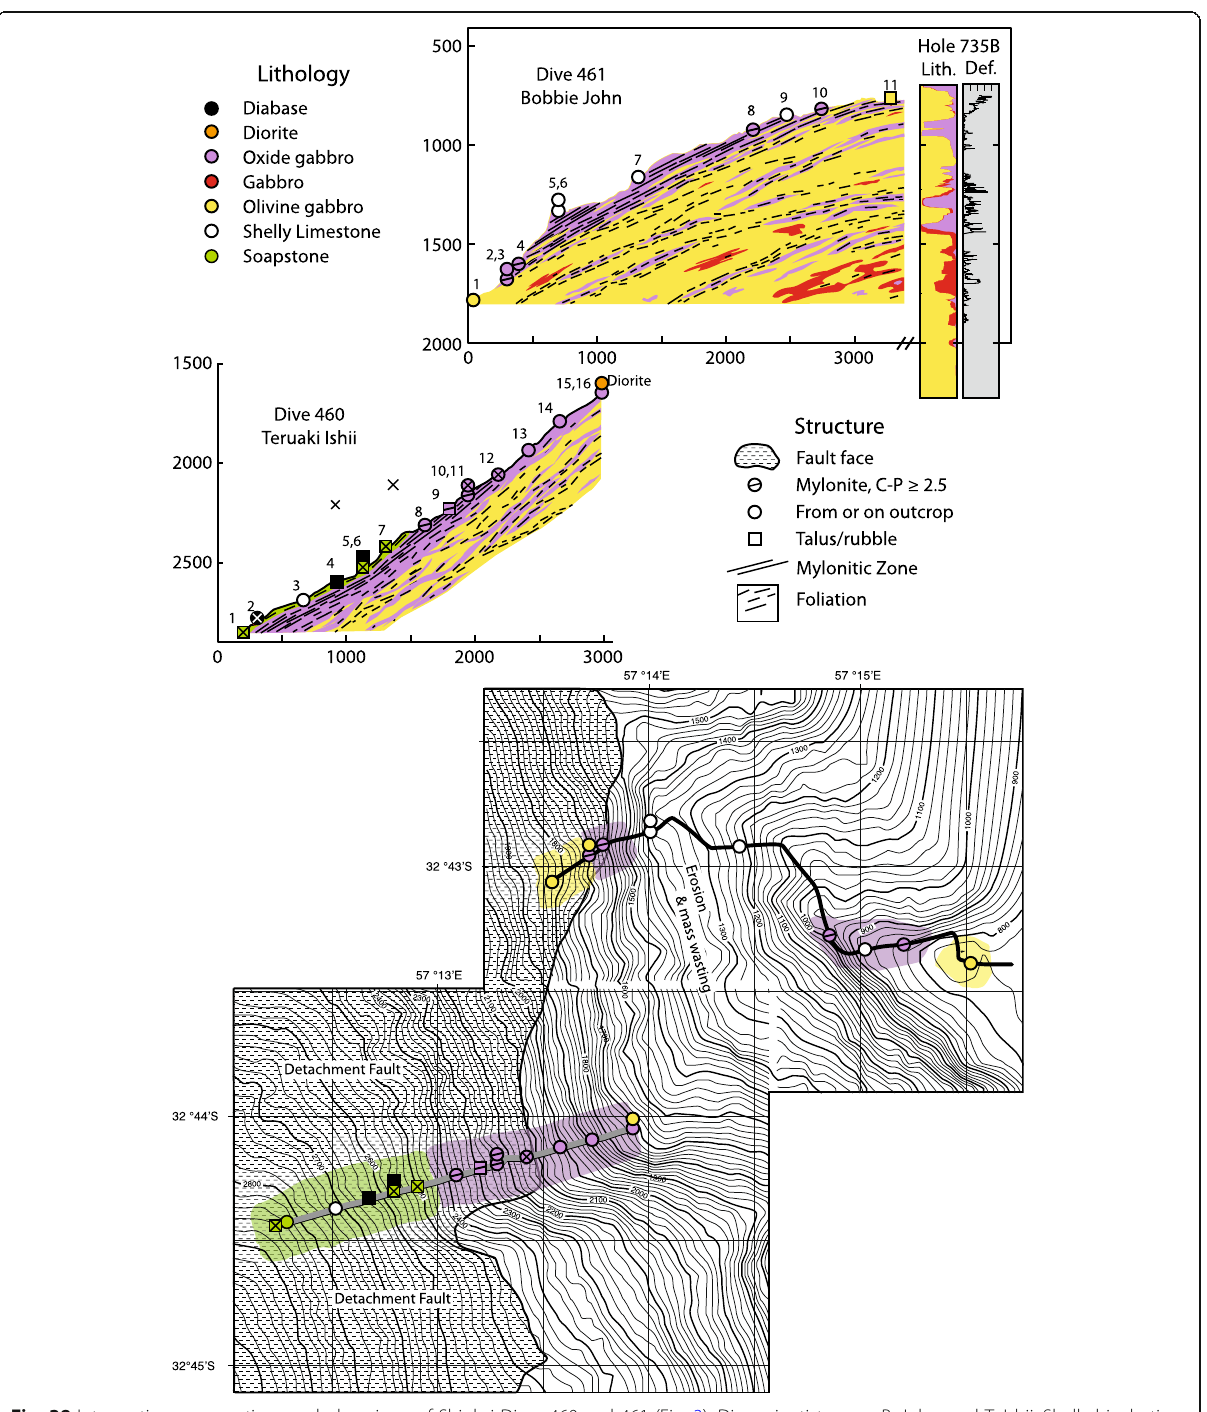
Fig. 38 Interpretive cross-sections and plan views of Shinkai Dives 460 and 461 (Fig. 3). Dive scientists were B. John, and T. Ishii. Shelly bioclastic limestone outcrops show that down to 2700 m depth, the rocks were once uplifted to the intertidal zone. Inset on the left of the Dive 461 profile shows the lithostratigraphic (Lith.) and crystal-plastic deformation (Def.) logs to scale for Hole 735B (Dick et al. 2000). As the dive tracks proceeded directly upslope on the uneroded to lightly eroded detachment fault surfaces, the approximate dip and strike of the footwall was measured directly off the tracks and profiles. Although the exposed foliations dip parallel to the slope on the dive tracks, in the upper 500 m of Hole 735B the foliation dips vary from 0 to 60°, with a median dip of around 30° (Dick et al.